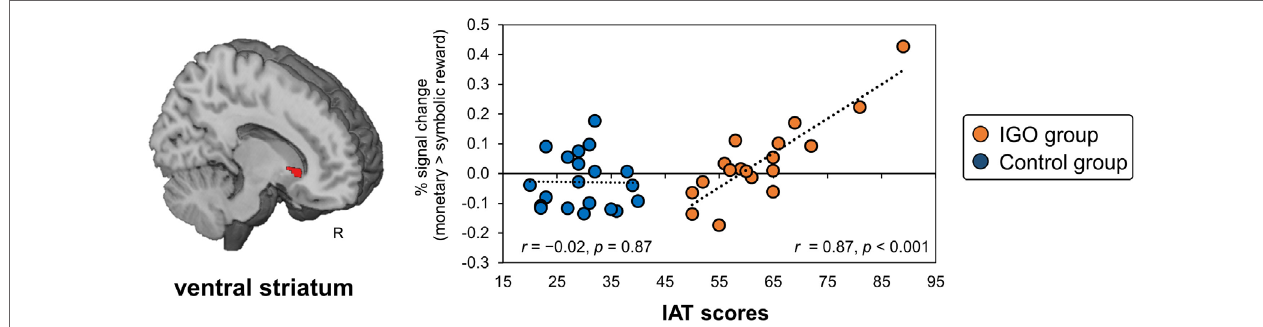
FigUre 5 | The relationship between ventral striatum (VS) response bias for monetary reward and severity of Internet game overuse (IGO) symptoms. The greater differential activation in the right VS region for monetary relative to symbolic reward [for the contrast of (monetary reward > symbolic reward)] was associated with higher IAT scores in the IGO group, but not the Control group. IAT: Young’s internet addiction